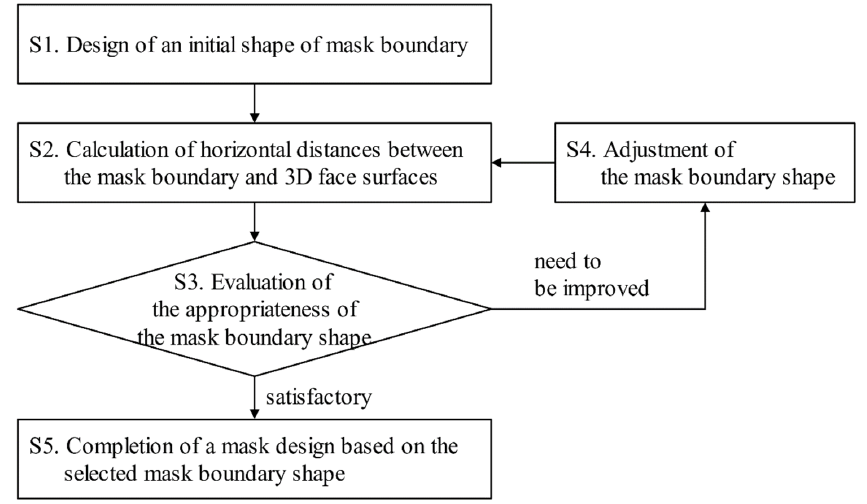
Figure 4. An ergonomic design process of a pilot oxygen mask by virtual fit analysis.